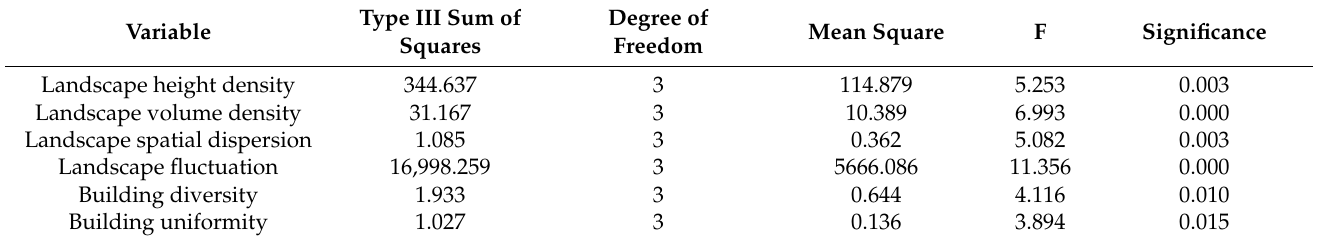
Table 5. Results of one-way ANOVA analysis.